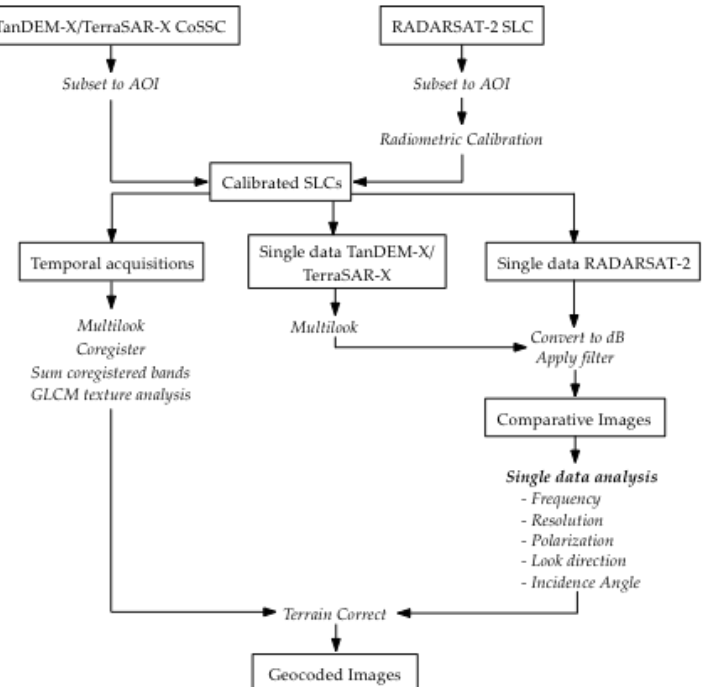
Figure 2 . Flowchart of processing chain. Figure 2. Flowchart of processing